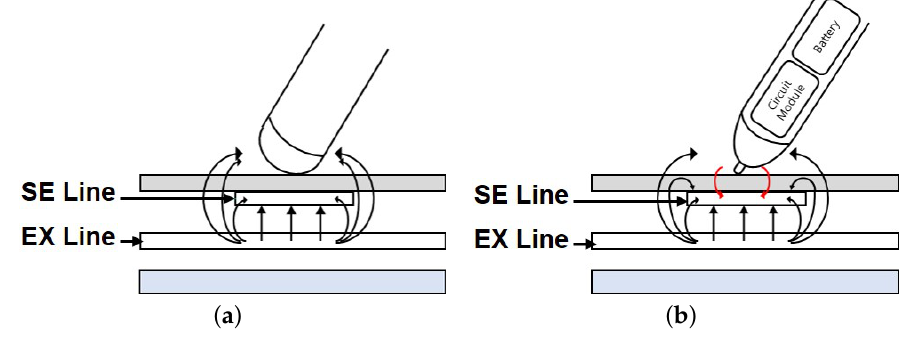
Figure 14. Stylus technologies for capacitive touchscreens. ( a ) Passive stylus. ( b ) Active stylus. If larger inverted pulses are applied to the tip, the different output voltage from finger-touch as well as no-touch will be obtained at charge amplifiers, which enables the stylus differentiation from the finger [106]. However, this scheme needs much higher voltage amplification at stylus circuits than EX pulses of the touchscreen to give rise to the additional voltage level required for the stylus discrimination. It reduces both dynamic range and SNR for the finger-touch detection when the ADC has the fixed input voltage range. In addition, the boosted voltage levels should be separately adjusted in accordance with